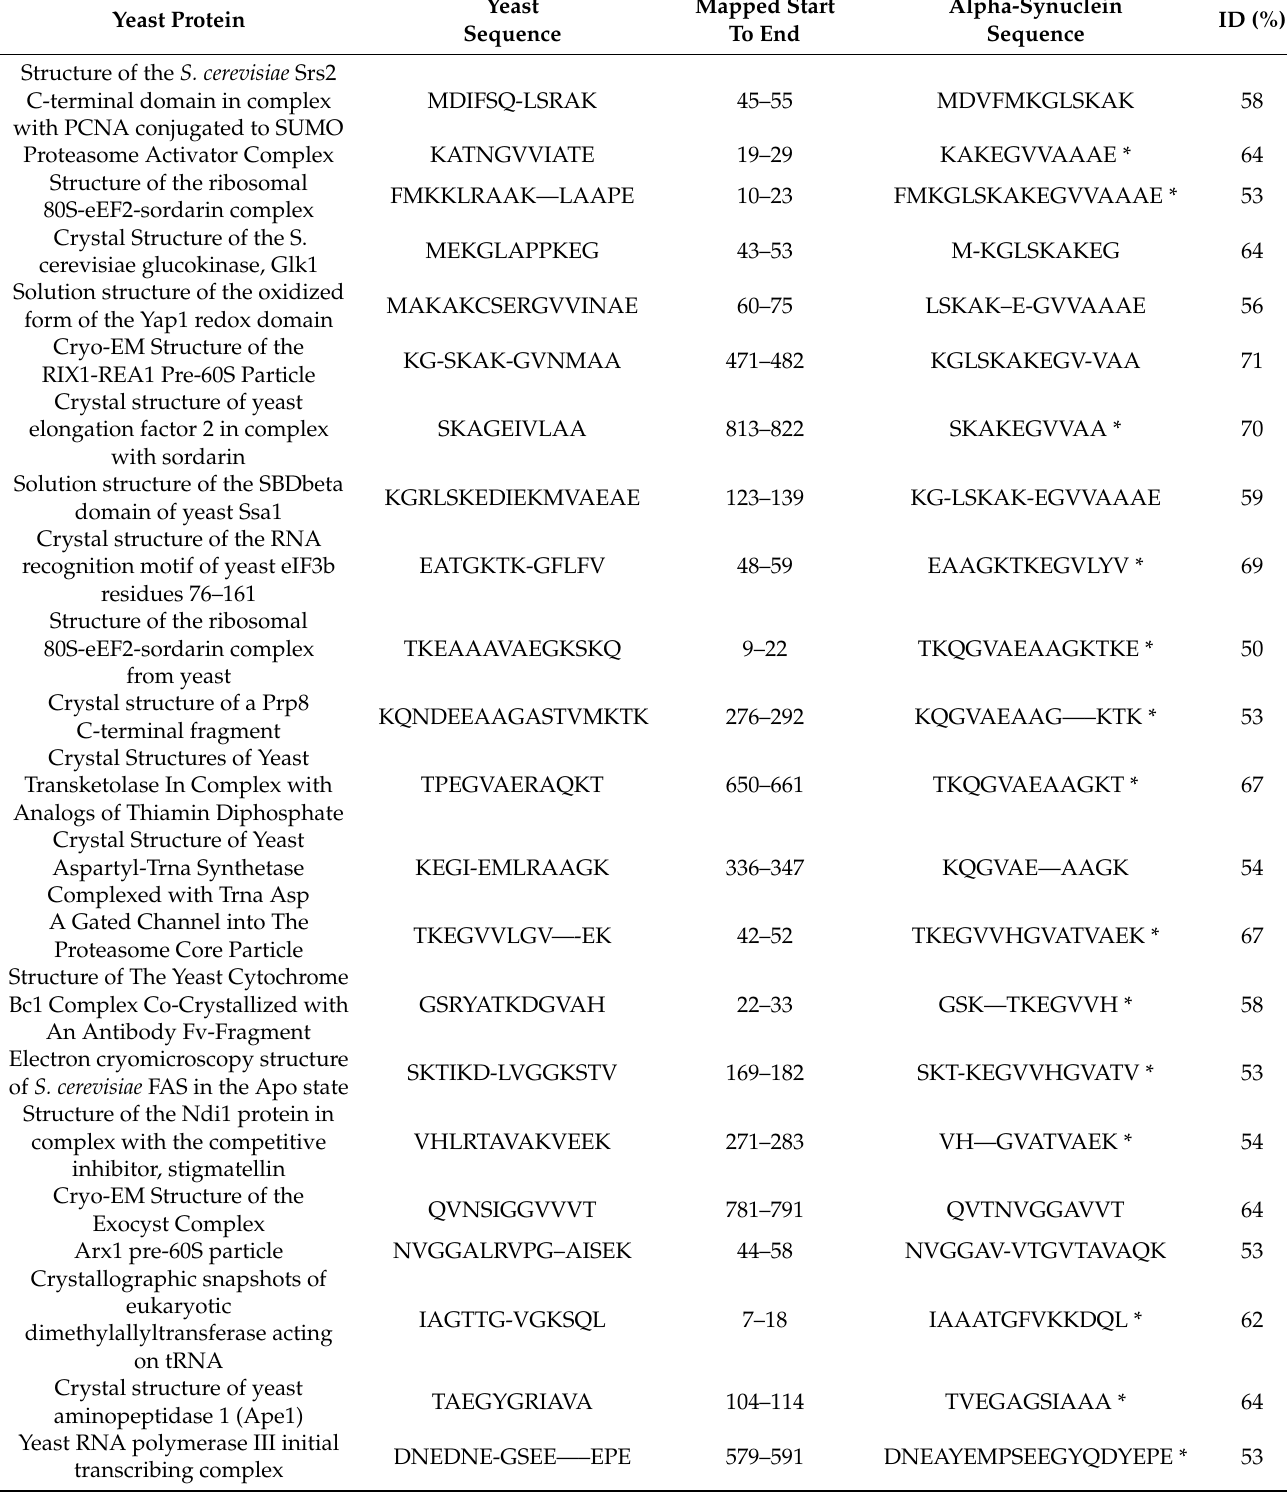
Table 1. Potential cross-reactive epitopes between alpha-synuclein proteins and yeast